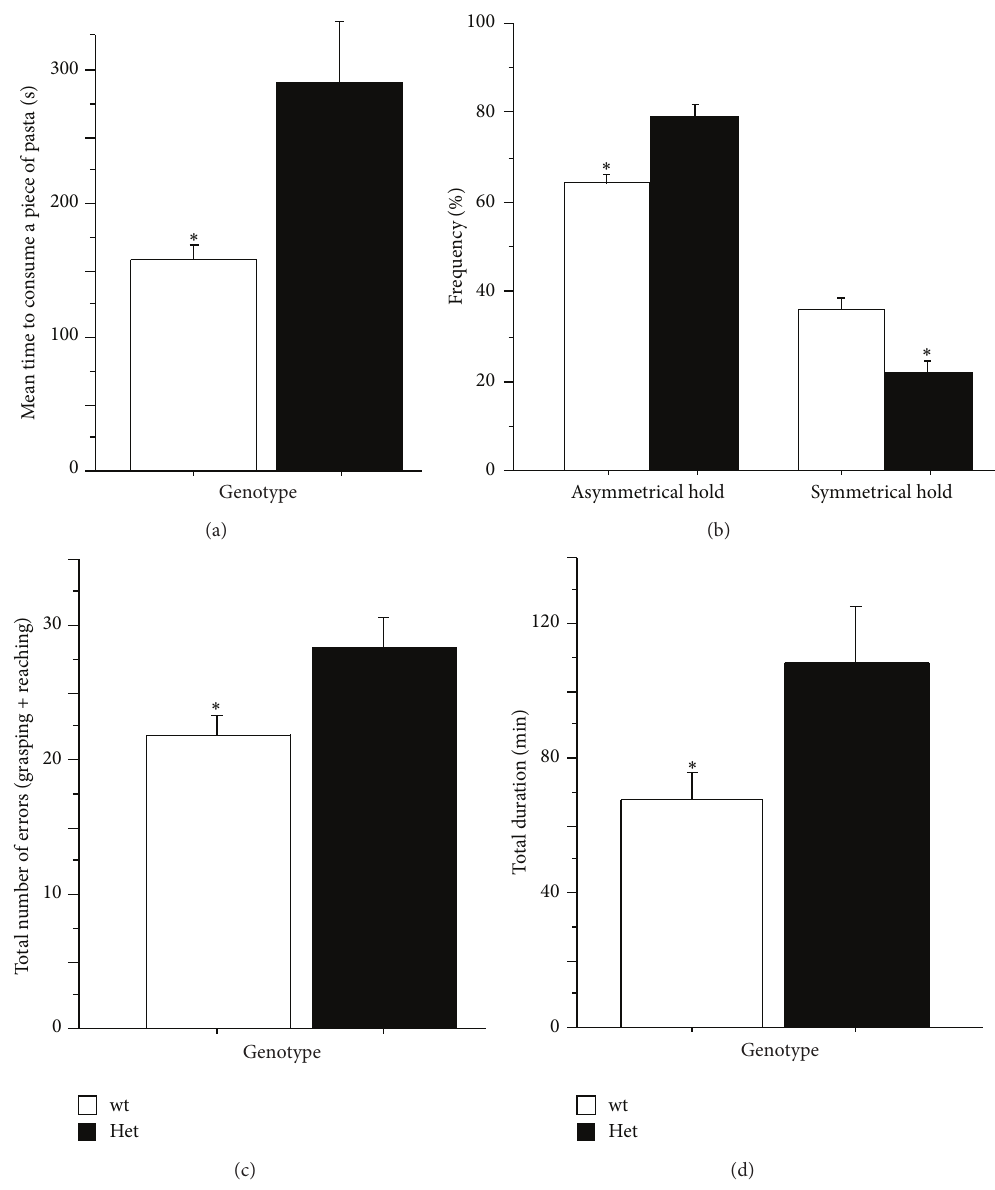
Figure 1: Skilled and purposeful forepaw use and coordination in the Morag test and the Capellini handling task. In the Capellini handling task, MeCP2-308 Het female mice (Het) needed more time to consume a piece of pasta compared to wild-type mice (wt) (a). Het mice also showed an atypical handling pattern compared to wt (b), as demonstrated by a higher number of asymmetrical holds (sum of grasp paw and one paw hold positions) and a significantly lower number of symmetrical holds (the mouse held the piece of pasta with both forepaws using a symmetrical position). In the Morag test, Het needed more time to collect 30 rewards ( total duration ) (d) and performed a higher number of total number of errors (sum of incorrect reachings and incorrect graspings ) compared to wt controls (c). Data are expressed as mean ± SEM. ∗ 𝑃 < 0.05